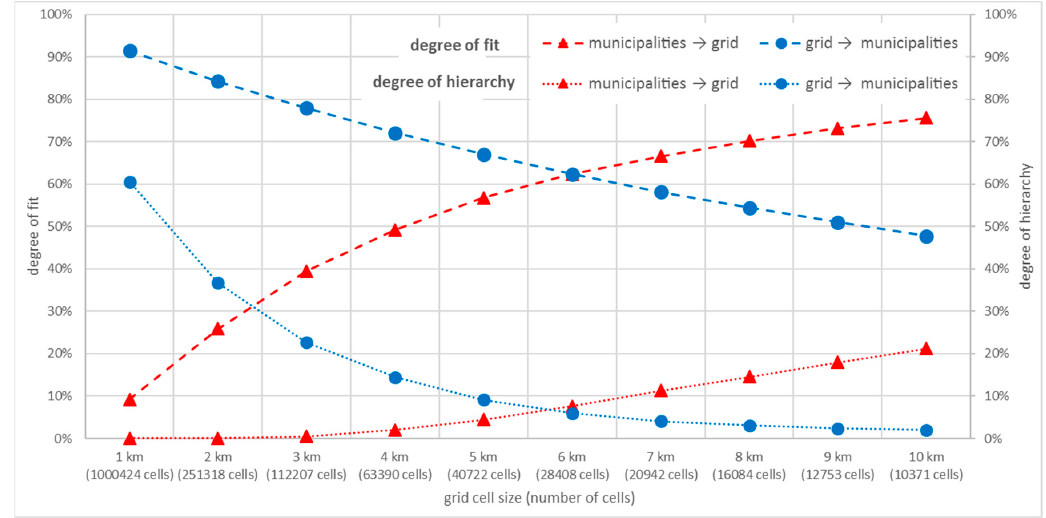
Figure 3. Degree of fit and degree of hierarchy between the regional structure of municipalities and the grid structures with different grid cell sizes.